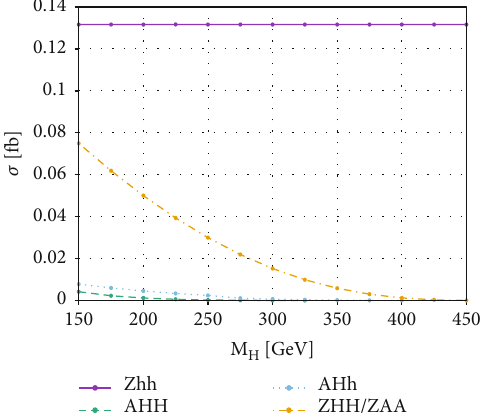
Figure 18: The distribution of cross-section as a function of tan β at ffiffi p = 1 TeV , where s s